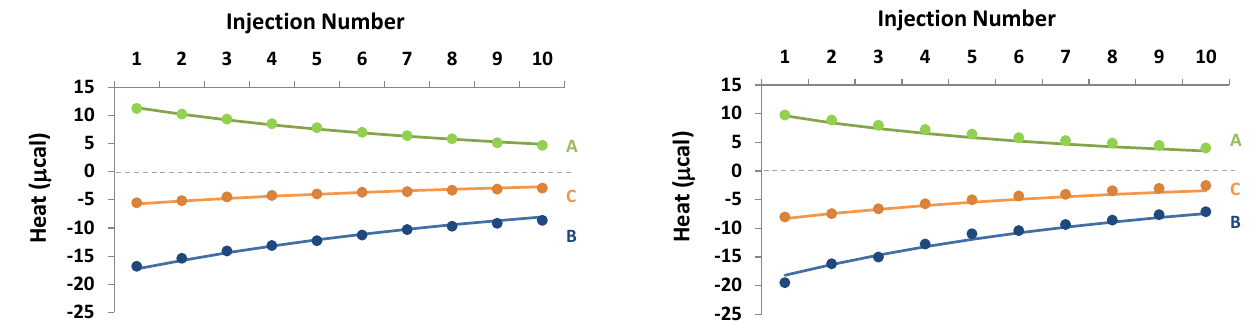
Figure 11. Experimental (dots) and theoretical (curves) ITC isotherms obtained for carvedilol/ γ CD ( left ) and carvedilol/RAMEB ( right ) systems at 298 K in acetate buffer, according to protocol A (0.5 mM carvedilol in the cell and 5 mM CD in the syringe, ), B (buffer in the cell and 1 mM carvedilol + 5 mM CD in the syringe, ) and C (0.5 mM carvedilol in the cell and 1 mM carvedilol + 5 mM CD in the syringe, ).